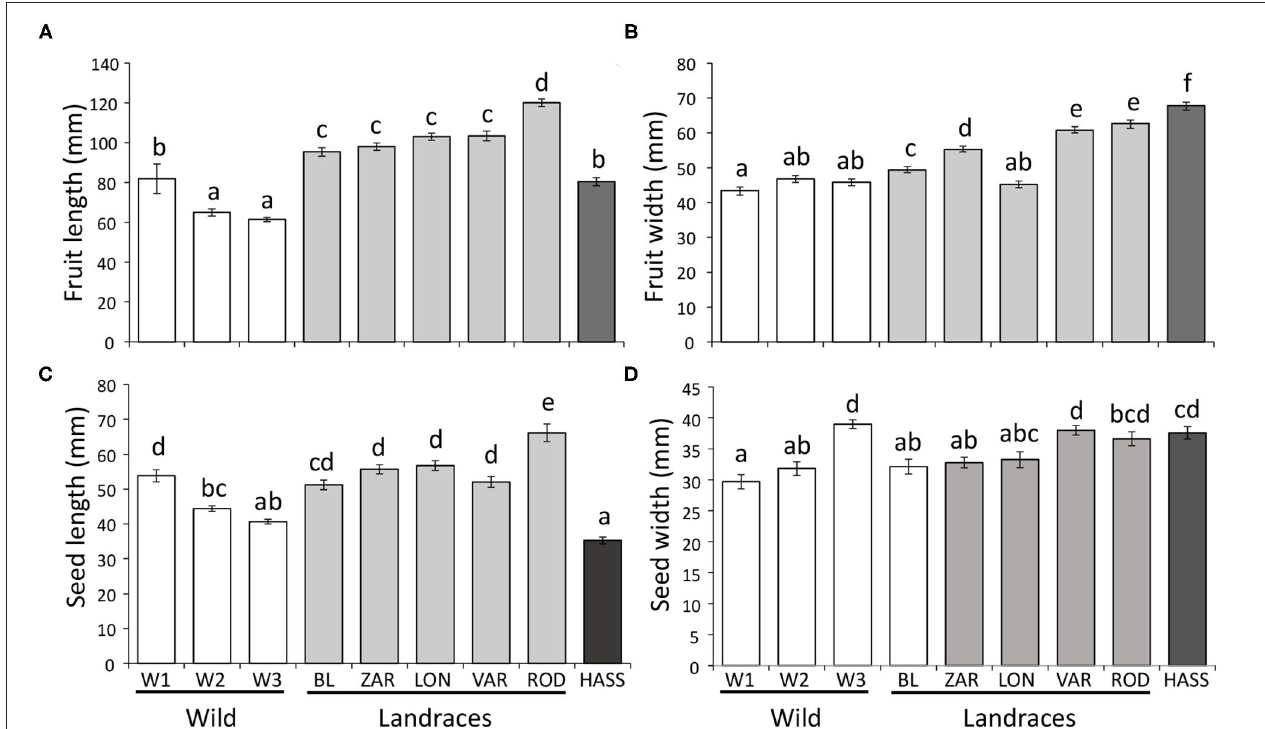
FIGURE 1 | Avocado ( Persea americana ) reproductive trait variation of different genotypes across a domestication gradient on (A) fruit length, (B) fruit width, (C) seed length, and (D) seed width. White bars = wild (ancestral) genotypes; gray bars = landraces (intermediate); dark bar = cultivated (modern) “Hass” variety. W1–W3 = wild populations 1–3; landraces: BL = “Blanco,” LON = “Lonjas,” ZAR = “Zarcoli,” VAR = “Vargas,” and ROD = “Rodolfo.” Bars are means ± SE per fruit. Different letters indicate significant differences among genotypes ( P ≤ 0.05), according to Tukey’s HSD post-hoc